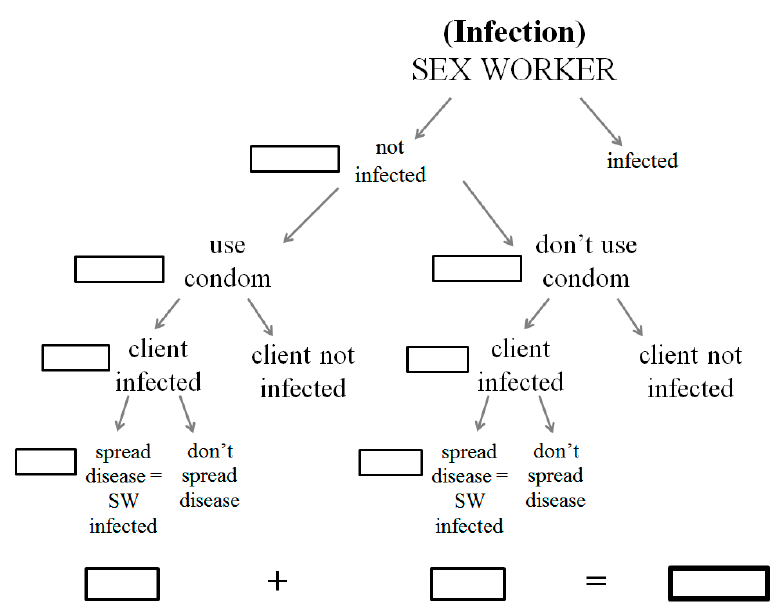
Figure A4. Probability tree of sex worker’s risk of infection.